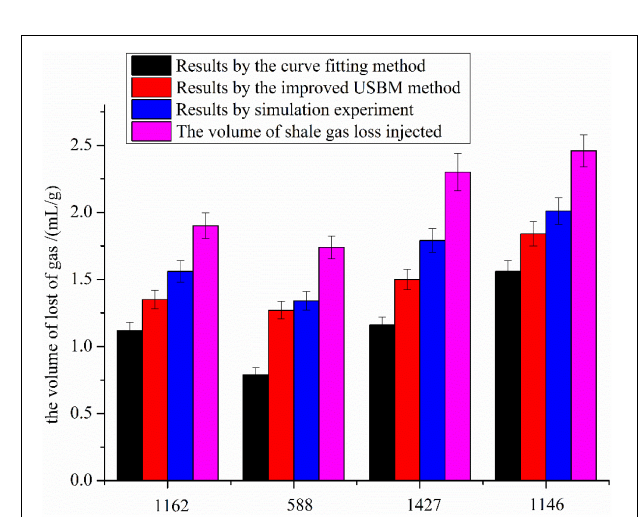
FIGURE 11 | The loss of gas volume in shale obtained by the improved USBM method.